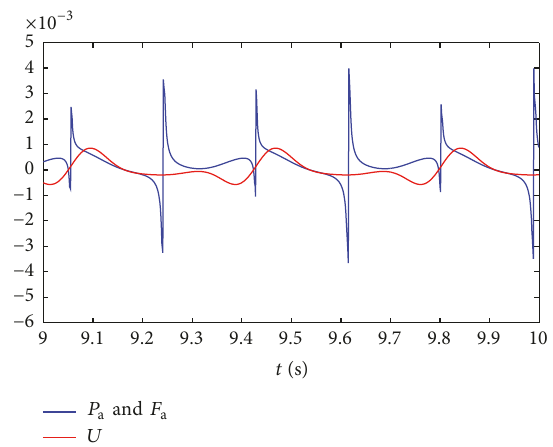
Figure 6: SDRE signal control to constant velocity ( 𝑥 2∗ = 16.83 rad/s = 20 km/h) with double-cylinder excited by pressure (normalized).